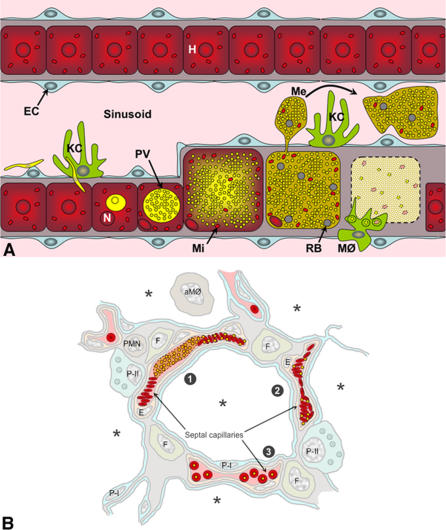
Model of Merosome Dissemination and Merozoite Liberation(A) After malaria sporozoite entry into a hepatocyte, the parasite begins to grow inside a PV to a size larger than its original host cell. Schizogonic division results in the formation of thousands of erythrocyte-infective merozoites. During the final stage of differentiation, the PVM dissolves and allows the parasites to mix with the remaining host cell organelles. Eventually, the plasma membrane of the infected hepatocyte bulges out and forms merosomes; thus releasing merozoites, remnant bodies, and host cell mitochondria into the sinusoidal lumen. Camouflaged by host cell membrane, merosomes are not recognized by Kupffer cells and are shuttled out of the liver. Infiltration of the remains of the infected host cell by mononuclear phagocytes and neutrophil granulocytes gives rise to the formation of a small granuloma. Me, merosomes; RB, remnant bodies; Mi, host cell mitochondria; KC, Kupffer cells; M∅, mononuclear phagocytes; S, sporozoite.(B) Shear forces inside the hepatic and other larger veins cause the merosomes to break down into smaller units. After passing through the right heart, these small merosomes are arrested inside lung capillaries where (1) they eventually release infectious merozoites into the pulmonary microvasculature; (2) local stagnation of the blood flow due to capillary occlusion by merosomes may result in dense erythrocyte packing; and thus (3) facilitate merozoite infection. ∗, alveolar space; H, hepatocyte; N, nucleus; E, endothelium; P-I, type I pneumocyte; P-II, type II pneumocyte; F, fibroblast; aM∅, alveolar macrophage; PMN, polymorphnuclear macrophage.